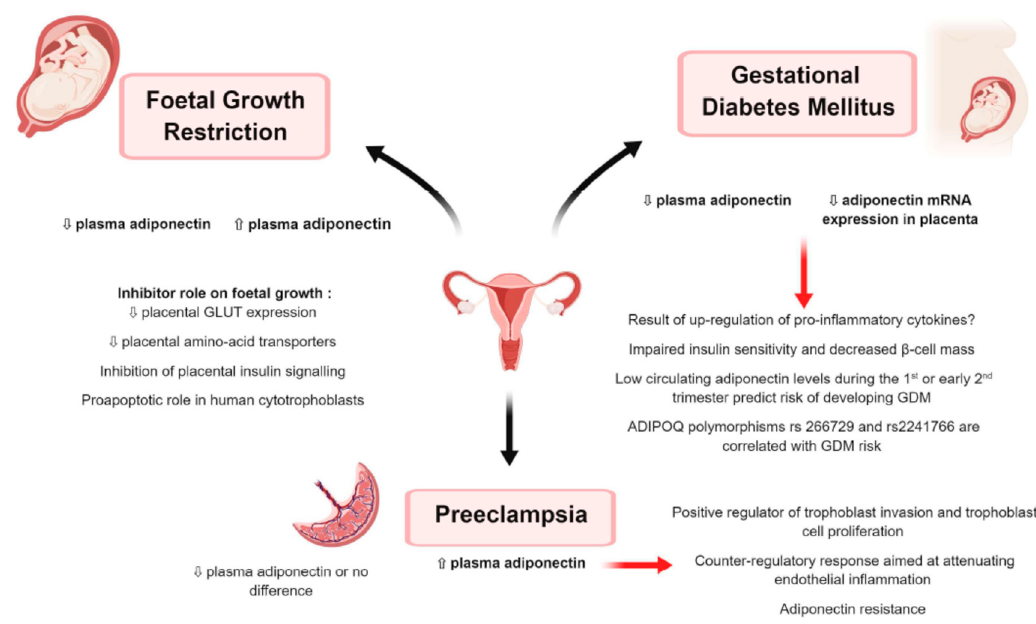
Figure 3. Adiponectin receptors and some examples of biological effects of adiponectin in reproductive tissues or cells. Adiponectin interacts with adiponectin receptors (mainly AdipoR1 and AdipoR2) to activate or inhibit a number of signalling pathways. T Cadherin receptor (T Cadherin R) binds the hexameric and high molecular weight isoforms of adiponectin but it has no intracellular domain. AdipoR1- and R2-dependent signalling is mediated through APPL 1 and APPL2. In the absence of adiponectin signal, APPL2 can bind to the N-terminal domain of the adiponectin receptors or it can form an APPL1/APPL2 heterodimer which prevents the APPL1/adiponectin receptors binding. On the other hand, the binding of adiponectin to its receptors favours the dissociation of this heterodimer. In peripheral tissues, adiponectin receptors have differing affinities for specific forms of adiponectin. In the reproductive tissues the affinities for specific forms of adiponectin is unknown. However, in these tissues, adiponectin regulates different biological effects through various signalling pathways. ⇧ Increase/stimulation. ⇩ Decrease/inhibition. Figure 6. Plasma adiponectin in foetal growth restriction, preeclampsia and gestational diabetes mellitus (GDM) as compared to control patients ⇧ Increase/stimulation. ⇩ Decrease/inhibition. Gestational diabetes mellitus (GDM) is defined as “diabetes first diagnosed in the second or